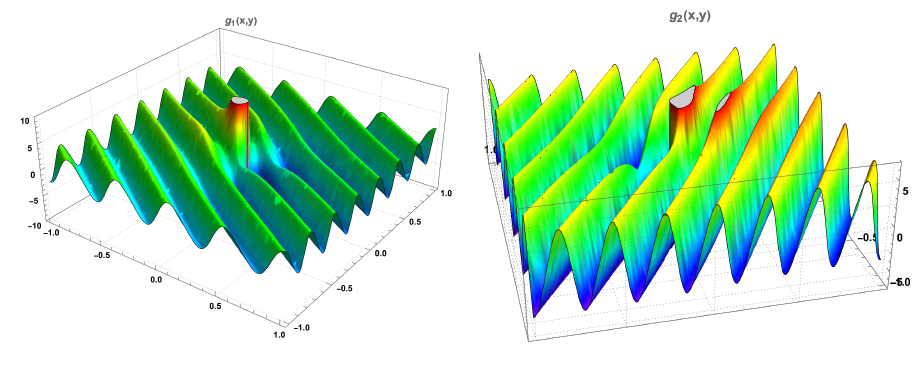
Figure 4. The functions g 1 and g 2